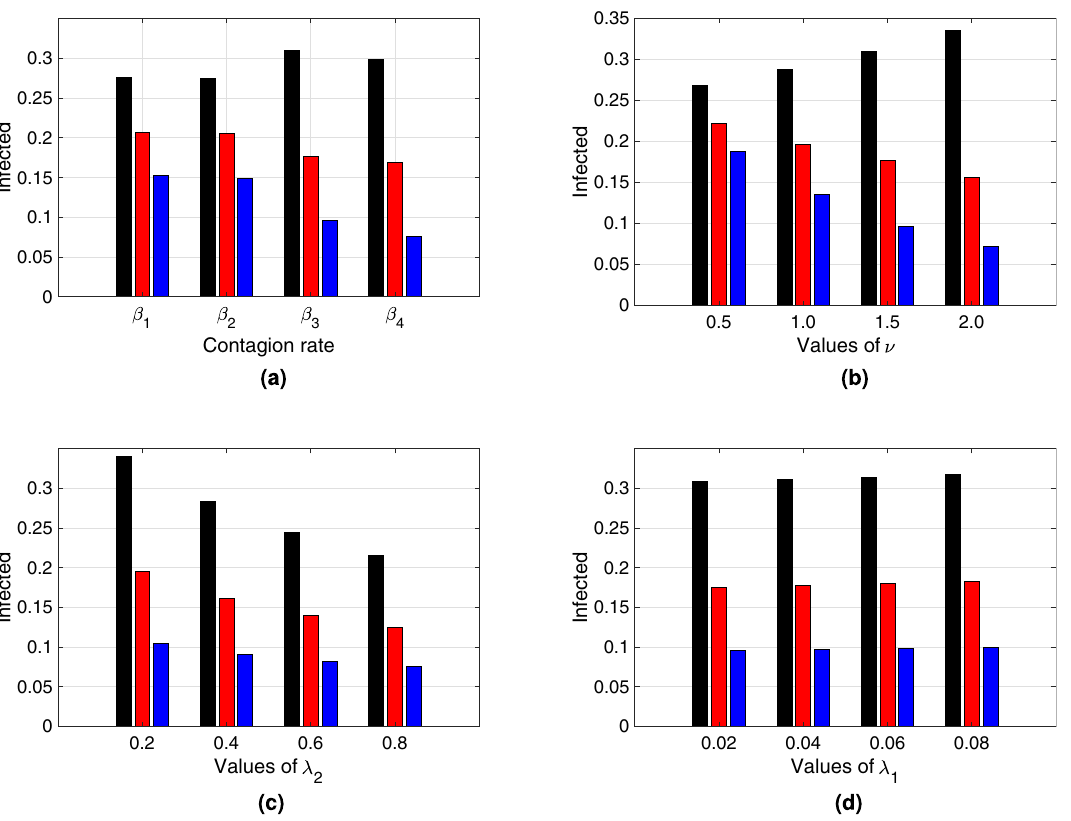
Figure 7. Size of the peak of a first epidemic outbreak from the system in Eq. (1) with respect to ( a ) contagion rates β i , i = 1, 2, 3, 4 , ( b ) measure of decrease of transmission rate with distance ν , ( c ) reaction velocity to change (cid:31) 2 , ( d ) rate of resistance to change (cid:31) 1 , for different society types: Black, red and blue bars correspond to D ∗ = 0.75 ( m ) , D ∗ = 1.05 ( m ) , and D ∗ = 1.35 ( m ) respectively. These correspond to societies of small ([0, 100)), medium ([100, 120]) and large ( [ 120, ∞ ) ) natural-distance types respectively (see Table 1). The height of each bar represents the size of the peak of the epidemic curve. The other parameter values were taken to be β ∗ = 0.5 and γ = 0.2 . For ( a ) (cid:31) 1 = 0.03 , ν = 1.5 , (cid:31) 2 = 0.3 . For ( b ) we used β 3 ( D ) as the transmission rate, (cid:31) (cid:31) D ) as the transmission rate, (cid:31) 1 = 0.03 and 2 = 0.3 . For ( c ) we also used β 3 ( 1 = 0.03 and ν = 1.5 . For ( d ) (cid:31) D ) as the transmission rate. The initial condition D ( 0 ) = D 2 = 0.3 , ν = 1.5 and β 3 ( ∗ was used for each type of